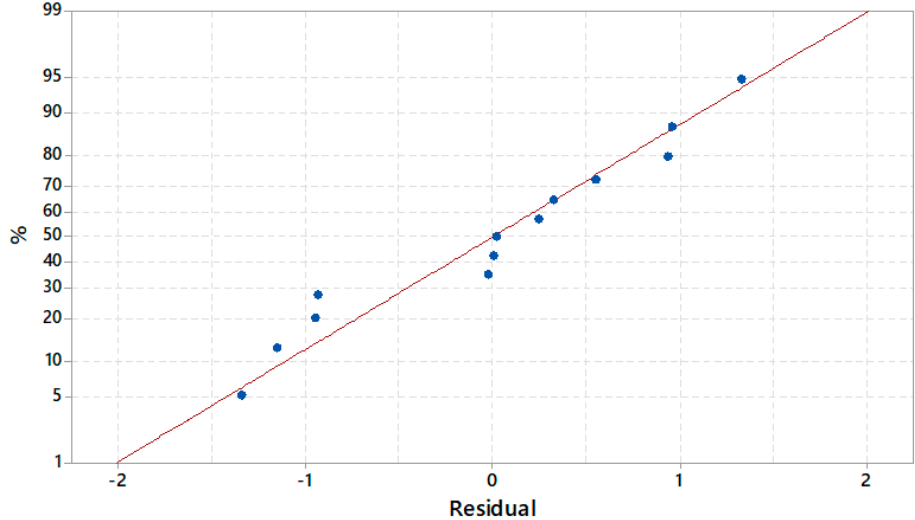
Figure 14. Q − Q plot of residual in Model (2).